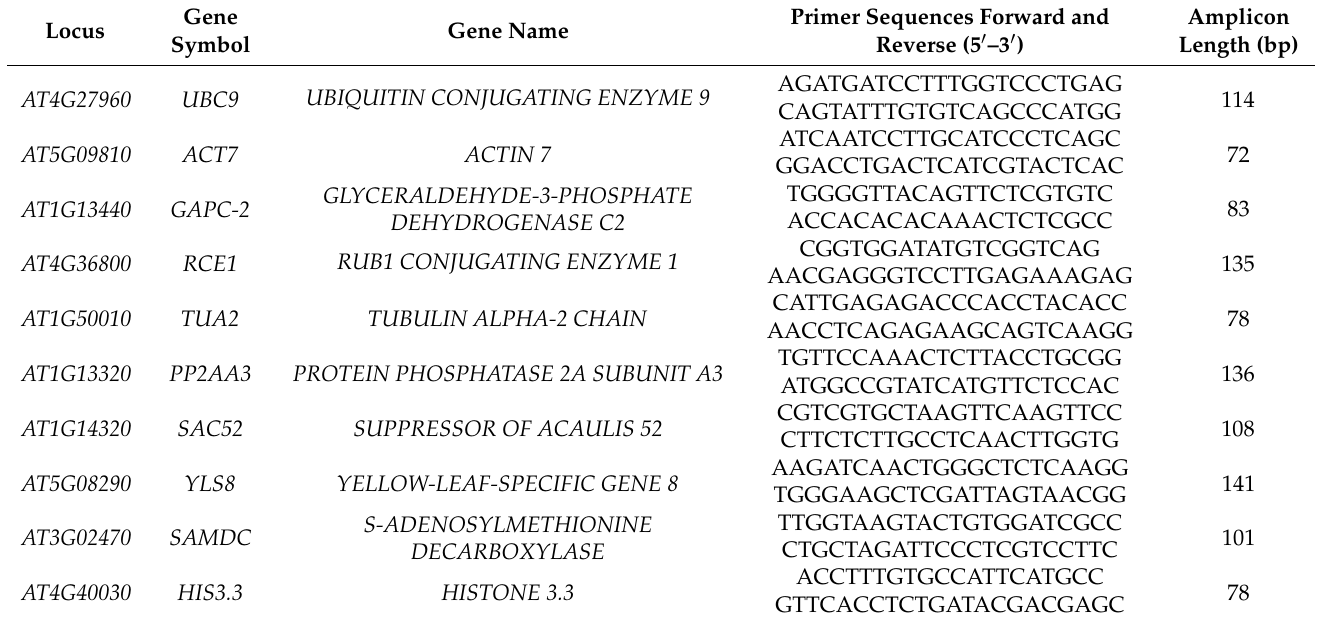
Table 1. List of candidate reference genes and primer sequences used in the qPCR